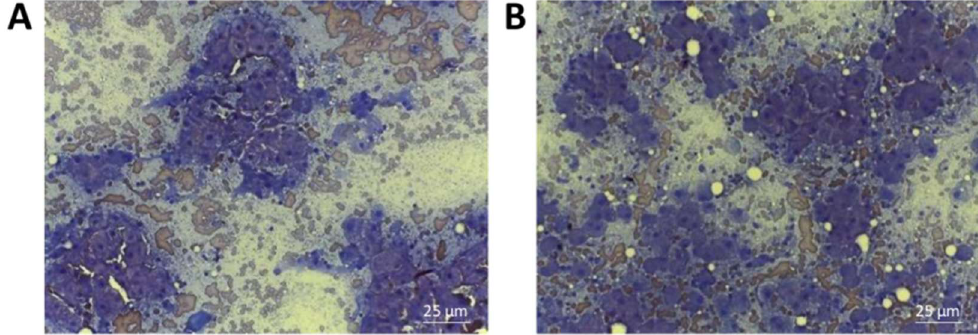
Figure 11. Representative images of cytological smears obtained from dogs affected by chronic liver disease. ( A ) Diff-Quik staining of hepatic smear performed before the first cell transplantation (magnification 40 × ). ( B ) Diff-Quik staining of hepatic smear performed 30 days after the second injection of cells (magnification 40 × ).